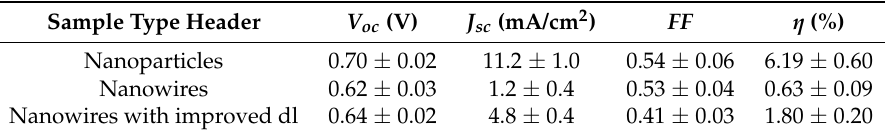
Table 1. Summary of the PV properties of the ZnO DSSCs.